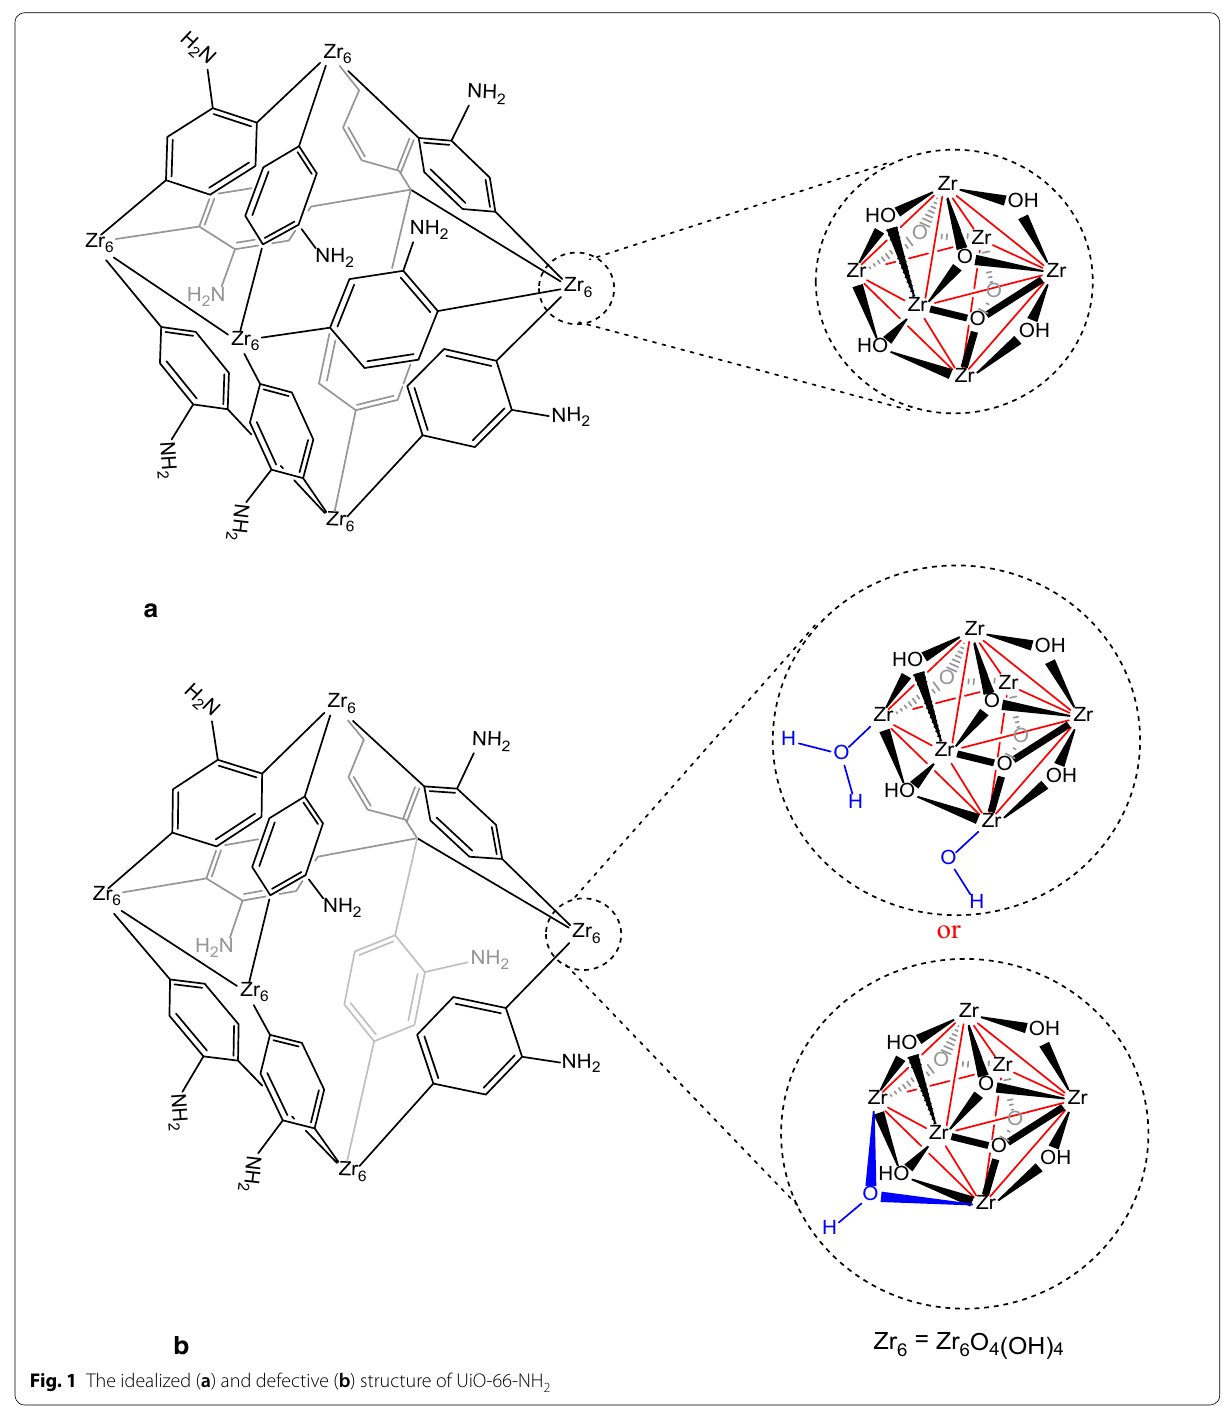
Fig. 1 The idealized ( a ) and defective ( b ) structure of UiO-66-NH